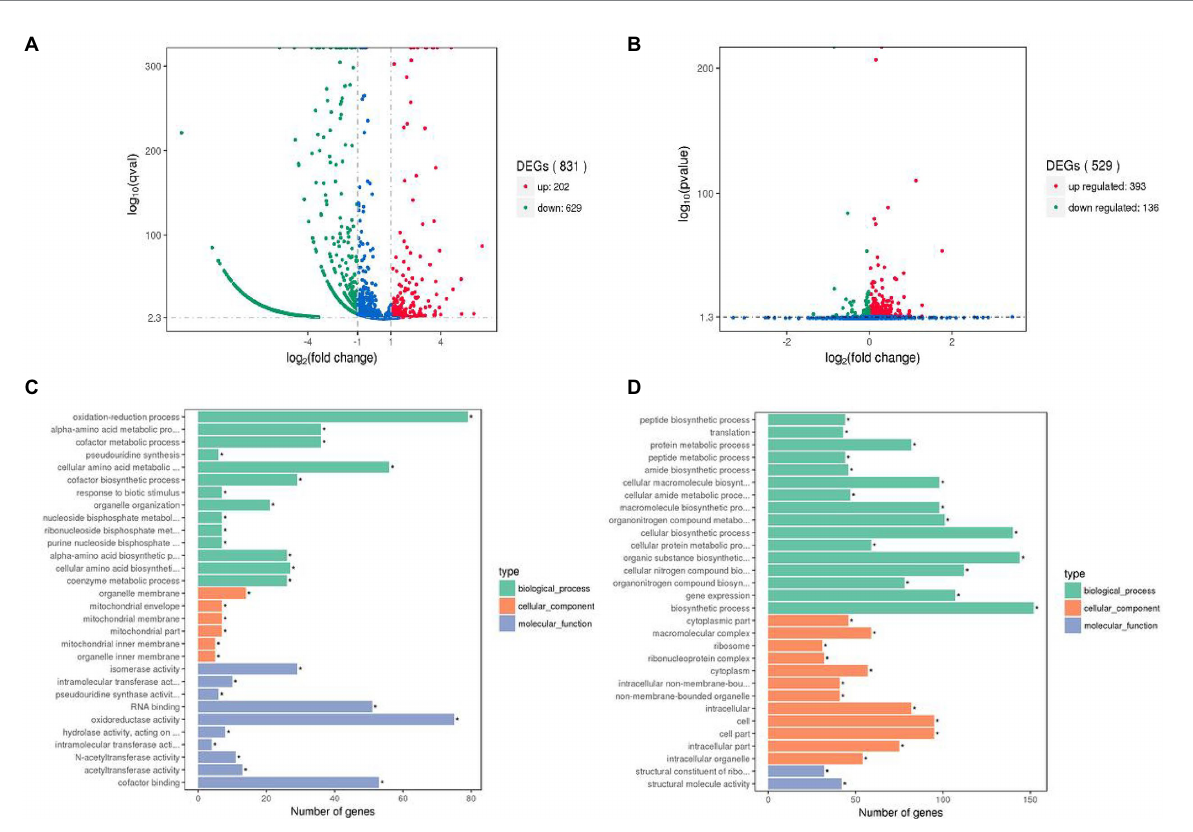
FIGURE 4 Gene expression profiles volcano map and the most enriched GO terms of differential genes. (A) Gene expression profiles volcano map of L. helveticus CGMCC 12062; (B) and A. pasteurianus CGMCC 3089; (C) Differential gene GO terms of L. helveticus CGMCC 12062; (D) and A. pasteurianus CGMCC 3089. |log2 (Fold Change)| > 1 and p value ≤ 0.05 was the criteria for transcriptome differential